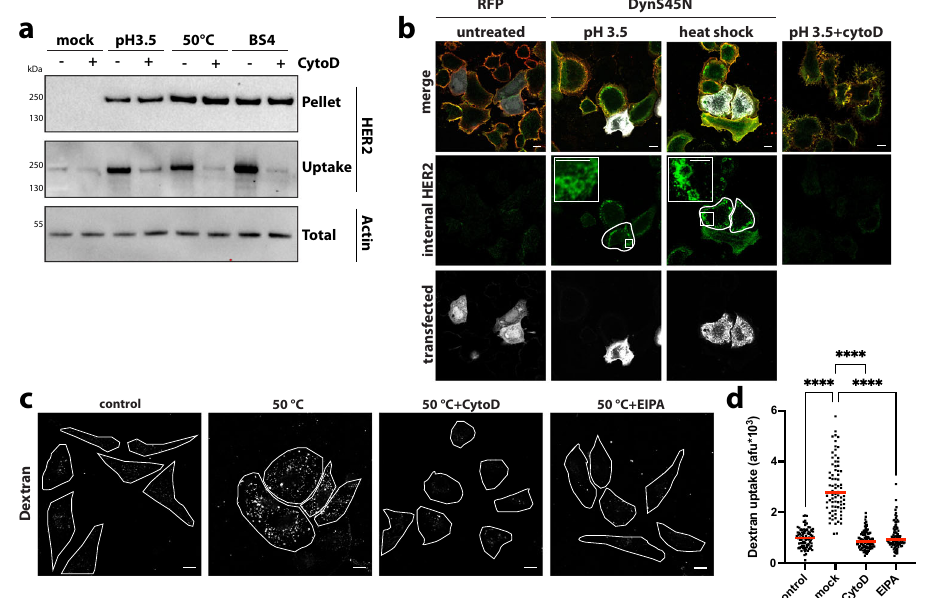
Fig. 9 | Stress-induced cell-surface receptor aggregates are endocytosed by ADE. a HER2 receptor aggregation and endocytosis upon chemical and physical stress. After surface biotinylation, SkBr3 cells±CytochalasinD (CytoD) were washed in an acidic buffer (pH 3.5), heat shocked for 5min (at 50°C), or treated with BS4. After incubation of all samples at 37°C for 30min, surface remaining biotinwasremovedandsampleslysedinlowdetergentbuffer.Afractionwasspun to precipitate insoluble/aggregated proteins (Pellet). Protein in the remaining sample wassolubilised (see “ Methods ” forprotocol)and endocytosedbiotinylated proteins concentrated on Streptavidin beads (uptake). Samples were assayed by immunoblot for HER2. b Stress-induced aggregation-dependent endocytosis occurs independent of dynamin but requires actin polymerisation. SkBr3 cells transfected with RFP control, or dominant-negative DynaminS45N N-terminally RFP tagged expression vector (RFP channel displayed in white) were heat shocked for 5min (at 50°C) or washed in an acidic buffer (pH 3.5)±CytochalasinD (CytoD)